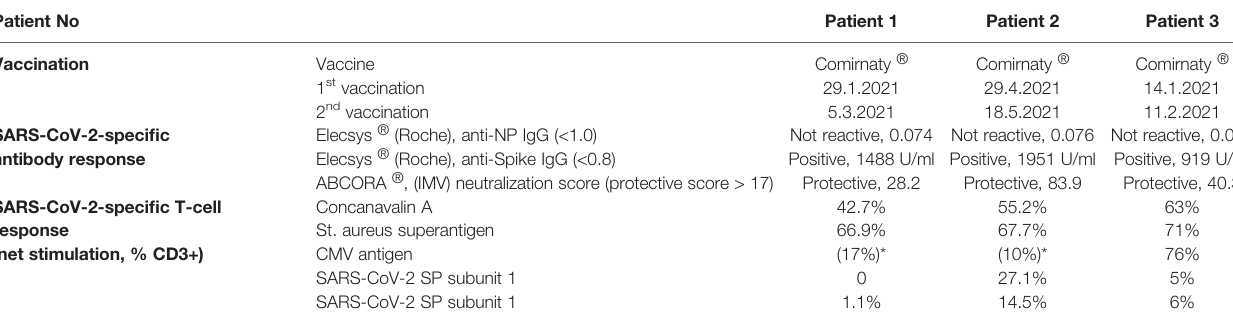
TABLE 3 | SARS-CoV-2-speci fi c vaccination and immunity. Patient